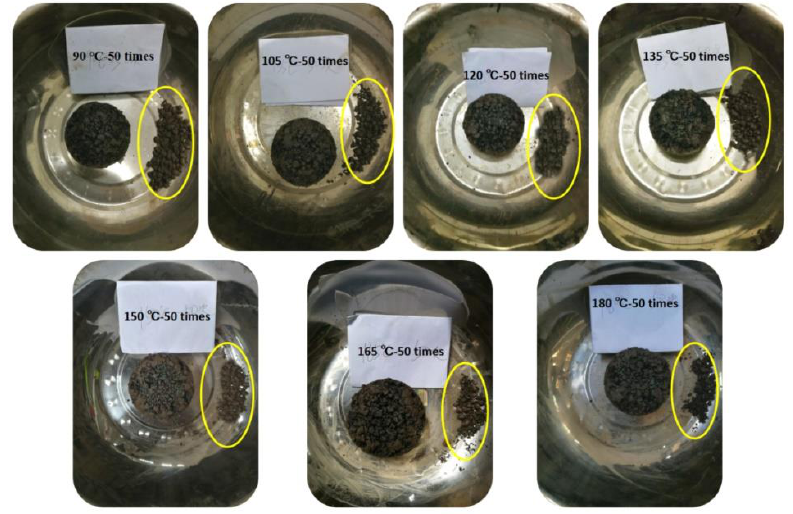
ff erent compaction Figure 8. Marshall sample Cantabro loss at different compaction temperatures. Figure 8. Marshall sample Cantabro loss at di Figure 8. Marshall sample Cantabro loss at different compaction temperatures.